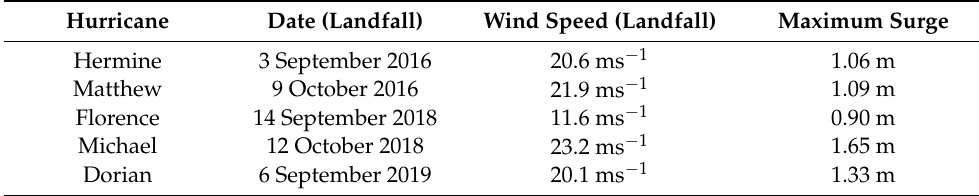
Table 3. Hurricanes that made landfall from 2016 to 2019 on or near the Pea Island study site. Hurricane Date (Landfall) Wind Speed (Landfall) Maximum Surge